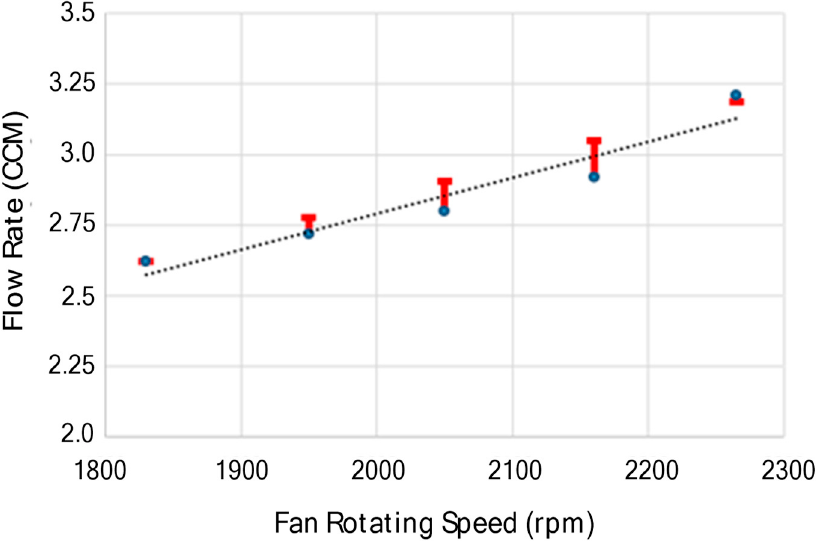
Figure 11. Fan flow rate for various fan rotating speeds.